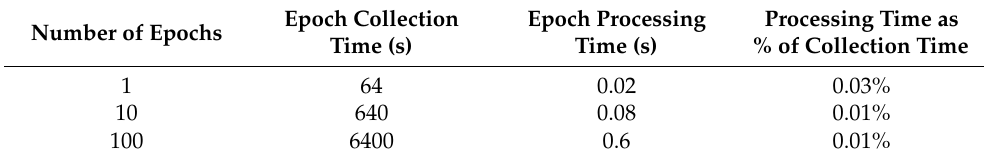
Table 2. Epoch collection and processing time (64 s